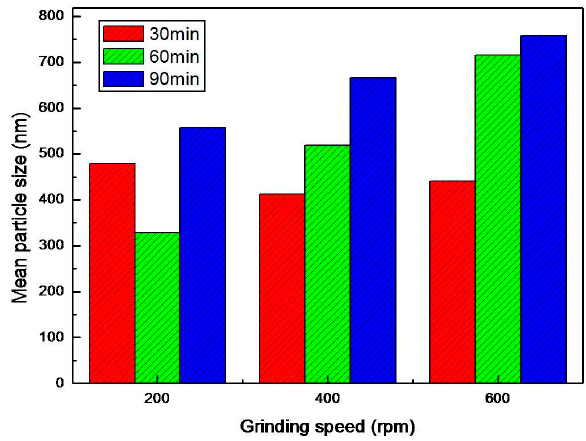
Figure 3. Influence of Experimental parameters on the mean particle size of GN structure.